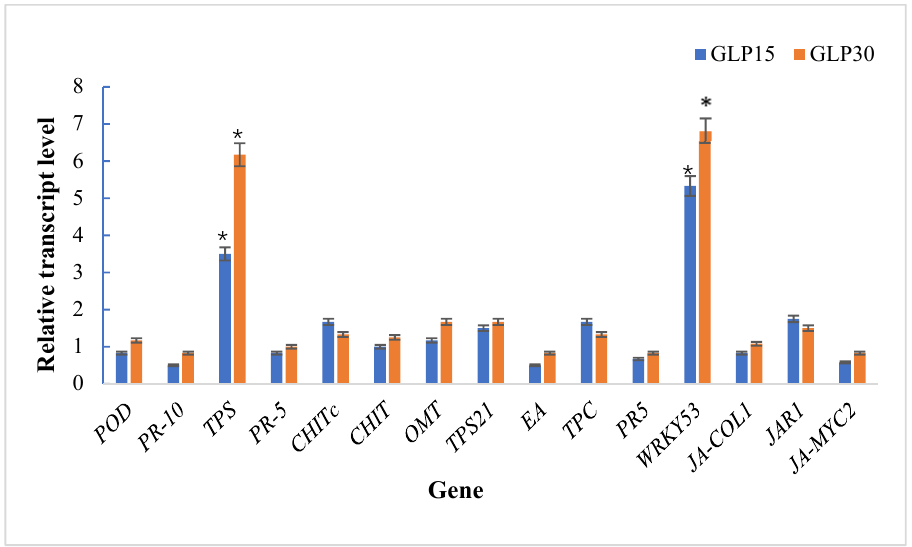
Figure 4. Effect of seed treated GLP on the transcript quantity of the maize (Zhengdan 958) disease resistance-related gene. GLP 15: 15% GLP, GLP 30: 30% GLP. * indicates significant difference at 0.05 level.